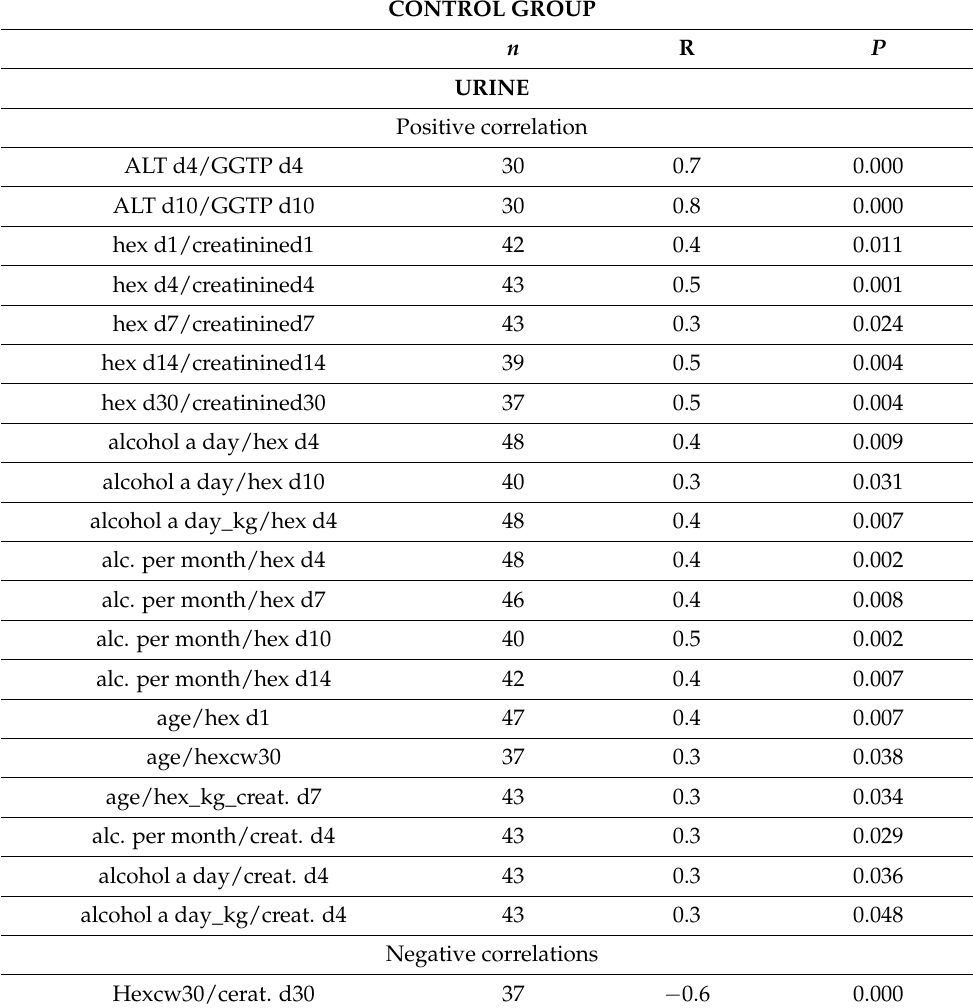
Table 4. Correlations of variables in the urine of the control